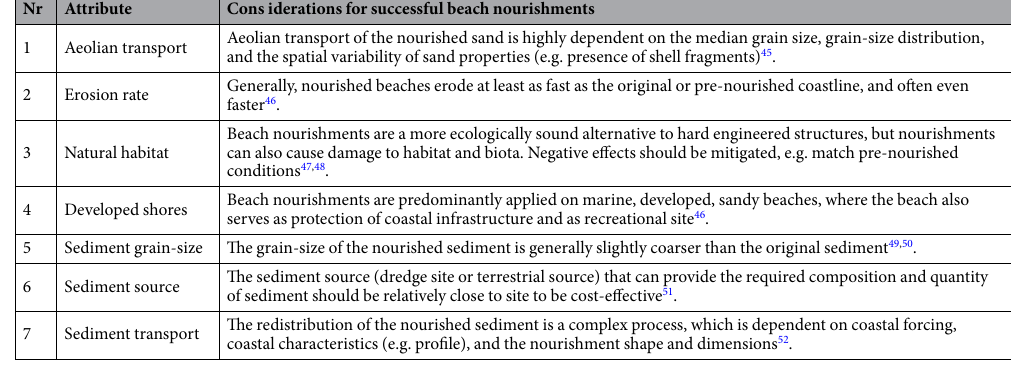
Table 2. Important (technical) considerations for sustainable (large) beach nourishments.